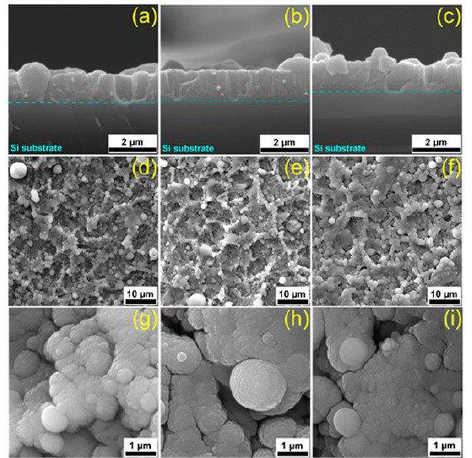
Figure 8. Cross-section ( a – c ) and top-view ( d – h ) SEM micrographs of ( a , d , g ) commercial HA, ( b , e , i ) Spa-BCP, and ( c , f , h ) Sal-BCP pulsed laser deposition (PLD) coatings, respectively. Reproduced with permission from [113]. Copyright MDPI,